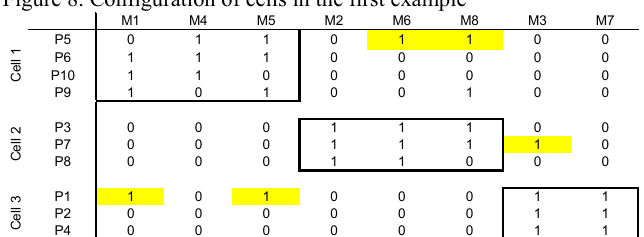
Figure 9. Configuration of cells in the second